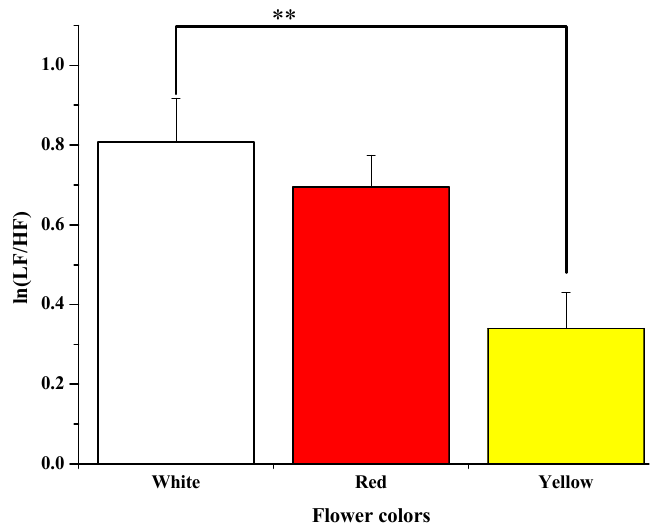
Figure 6. Average of ln(LF/HF) while seeing white, red, and yellow rose. ** p < 0.01 according to Bonferroni correction.